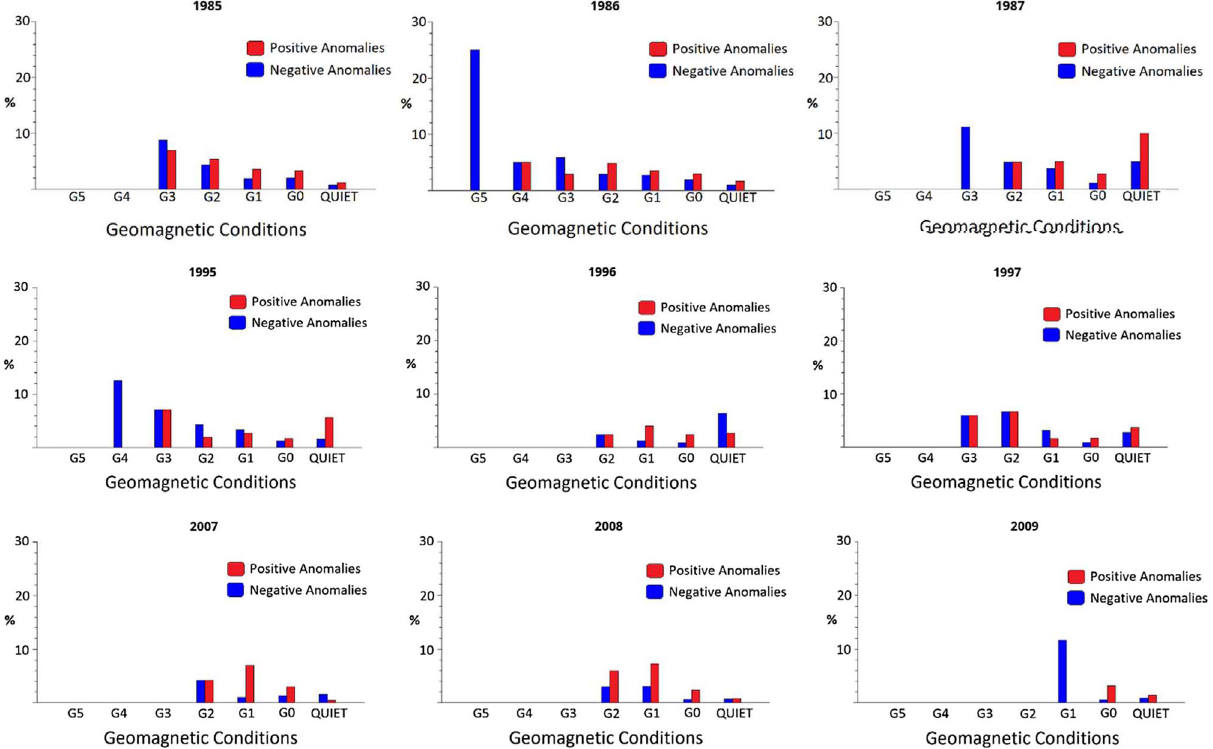
Fig. 3. In the panels are reported the percentages of both positive and negative foF2 anomalies, for the analysed years of the turn of solar cycles 21 – 22, 22 – 23 and 23 – 24.